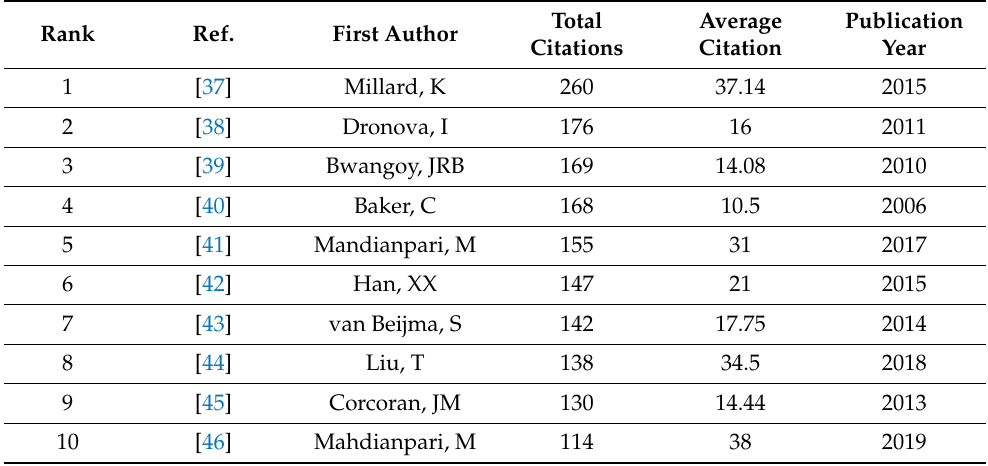
Table 3. List of highly cited papers in the database, ranked by the total number of citations (as of 30 June 2022). Rank